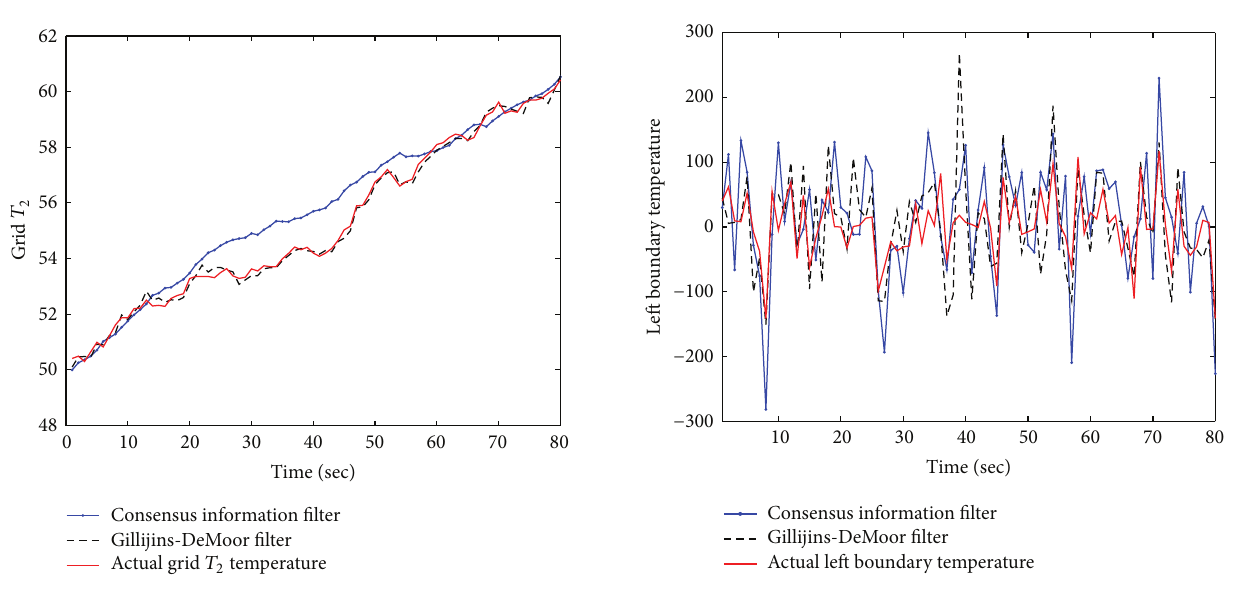
Figure 3: Temperature values of the second grid.